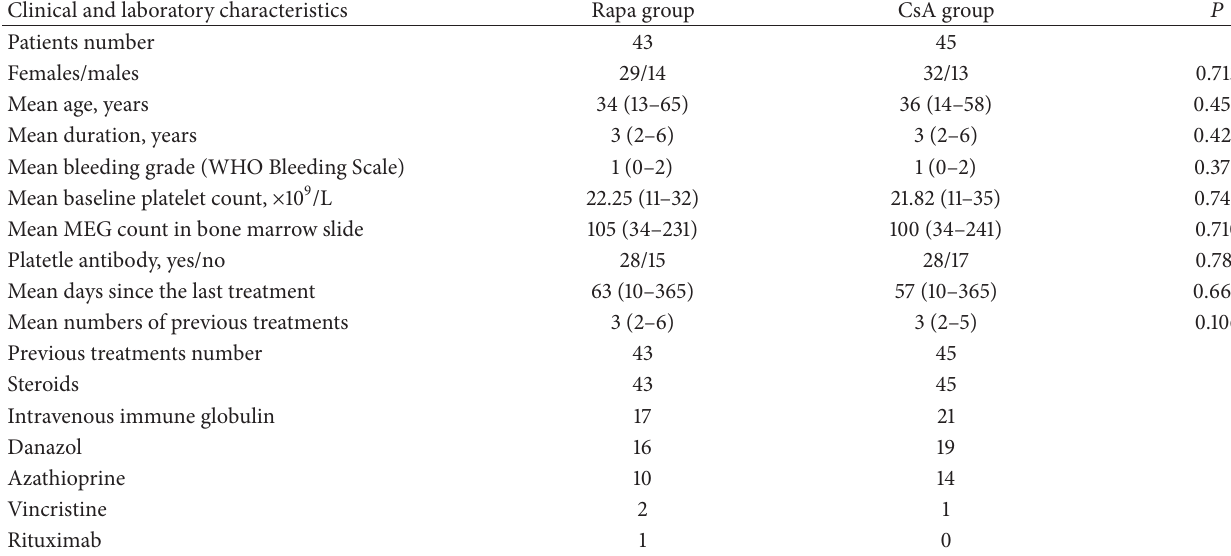
Table 1: Patient’s clinical and laboratory